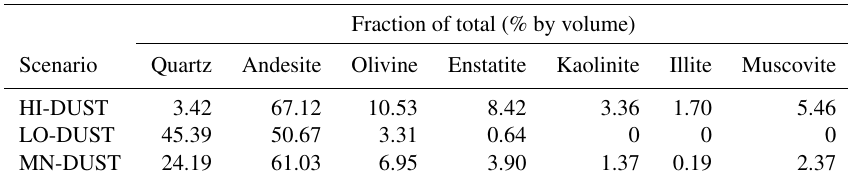
Figure 2. (a) Mass absorption coefficients of the major algal pigments including the purpurogallin-type phenol. (b) Measured spectral albedos for each surface type ( H bio is heavy biomass loading, L bio is light biomass loading, CI is clean ice and SN is snow). (c) Plot showing the natural logarithm of cell abundance against broadband albedo. (d) Microscope image showing examples of both algal species and mineral fragments from a melted H bio sample. Table 1. Composition of each mineral dust “scenario” in percent of total by volume. Fraction of total (% by